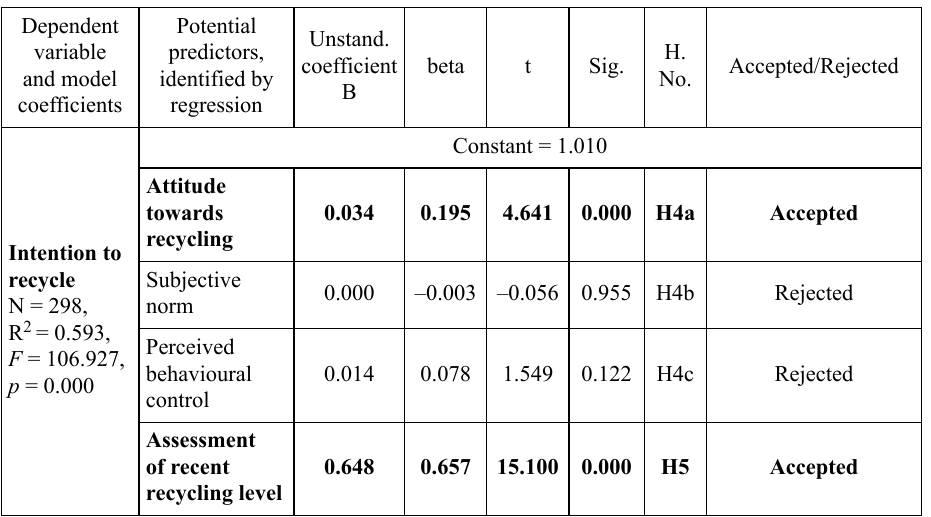
Table 8. Attitudes towards recycling, subjective norm, PBC, and assessment of recent recycling level as predictors of intentions to recycle: summary of multiple regression model